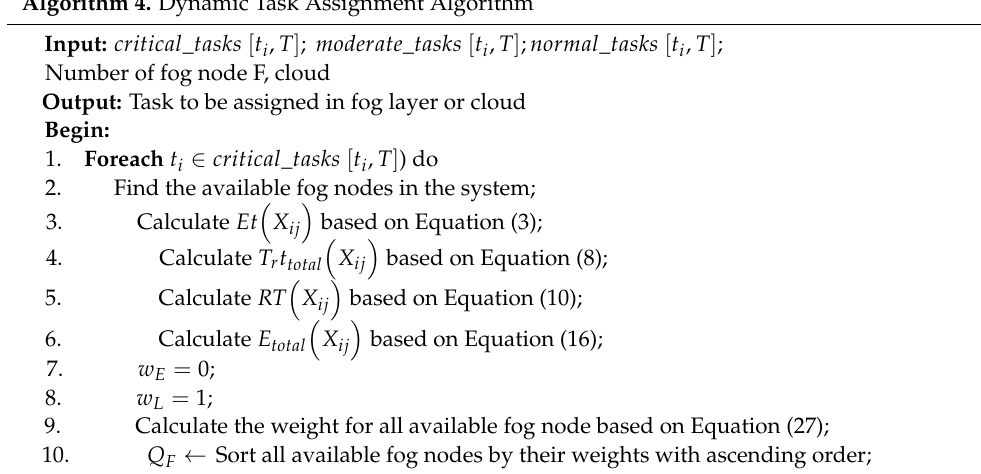
Algorithm 4. Dynamic Task Assignment